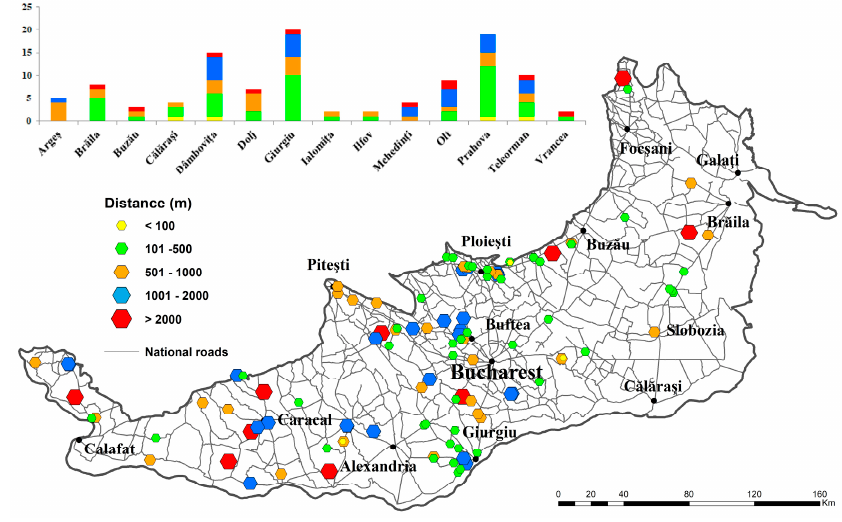
Figure 13. Distance of PV farms to national roads.